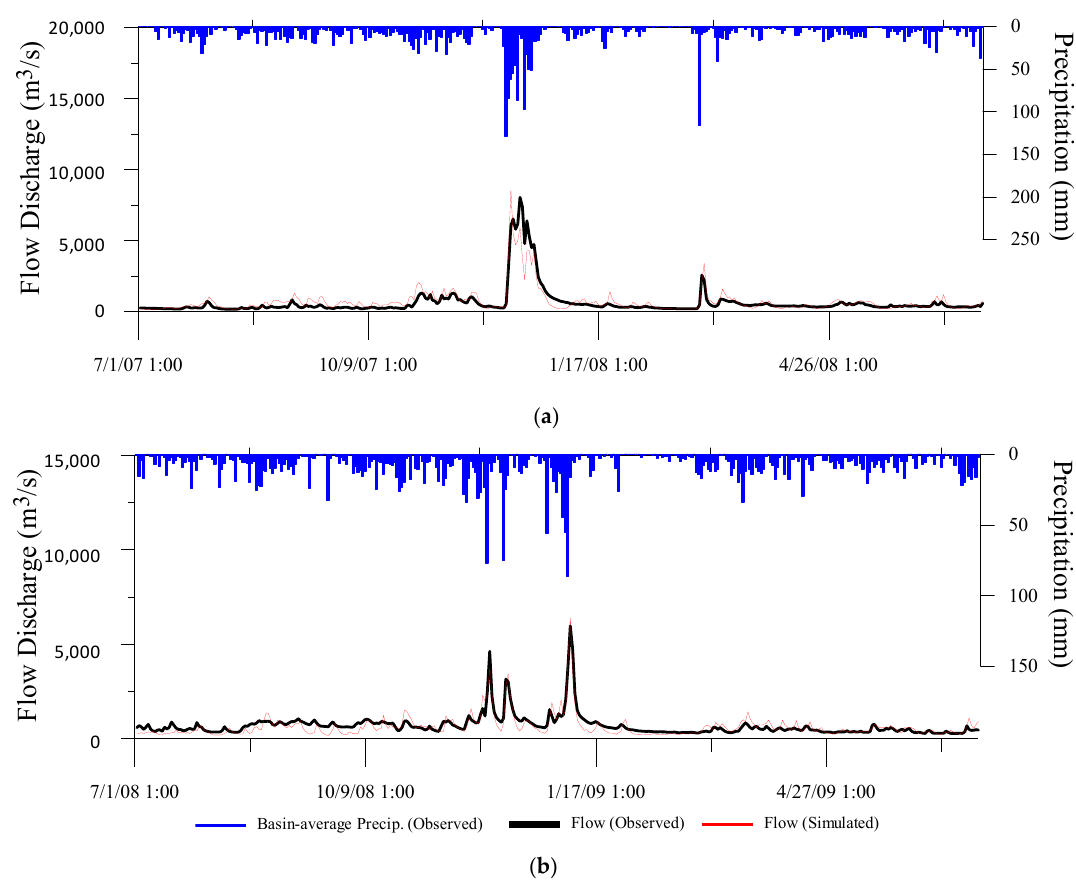
Figure 4. Calibration and validation results in hourly time series of the observed and model simulated stream discharges in m 3 /s (cubic meters per second, cms) at Jambatan Guillemard station in Kelantan watershed for the ( a ) calibration, and ( b ) validation periods. Basin average precipitation is given as the secondary Y-axis.